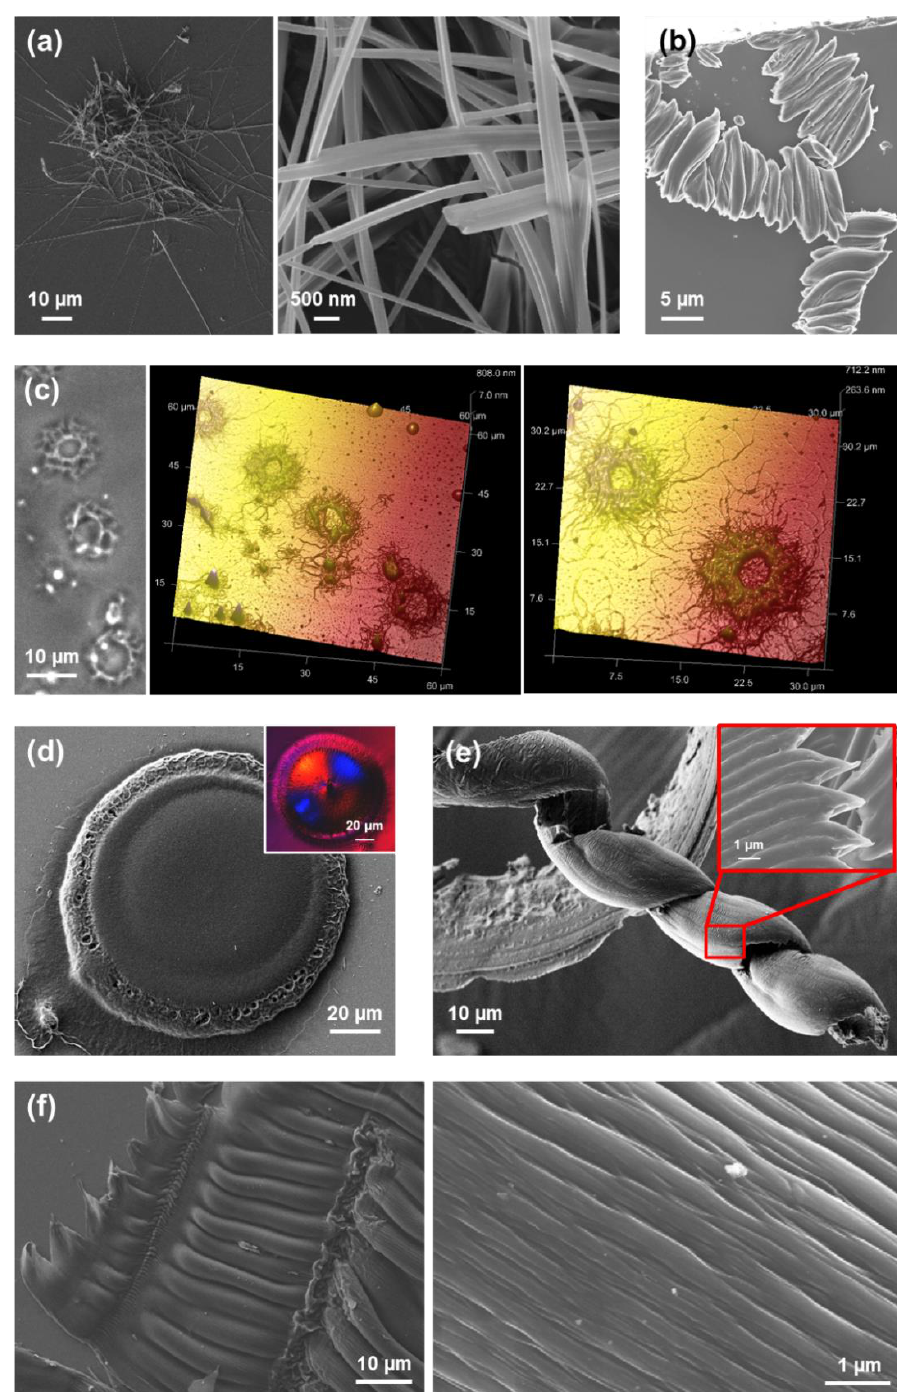
Figure 16. ( a , b , d , e ) SEM, ( c , d ) optical and ( c ) AFM (left: 60 × 60 µm 2 ; right: 30 × 30 µm 2 ) images of the structures obtained from Fmoc-FFF-OFm solutions in ( a ) 1:99 HFIP:water (0.05 mg/mL), ( b ) 1:4 HFIP:water (1 mg/mL), ( c ) 4:1 HFIP:water (4 mg/mL), ( d ) HFIP (5 mg/mL), ( e ) 4:6 HFIP:EtOH (2 mg/mL), and ( f ) 1:9 HFIP: i PrOH (0.5 mg/mL) mixtures.